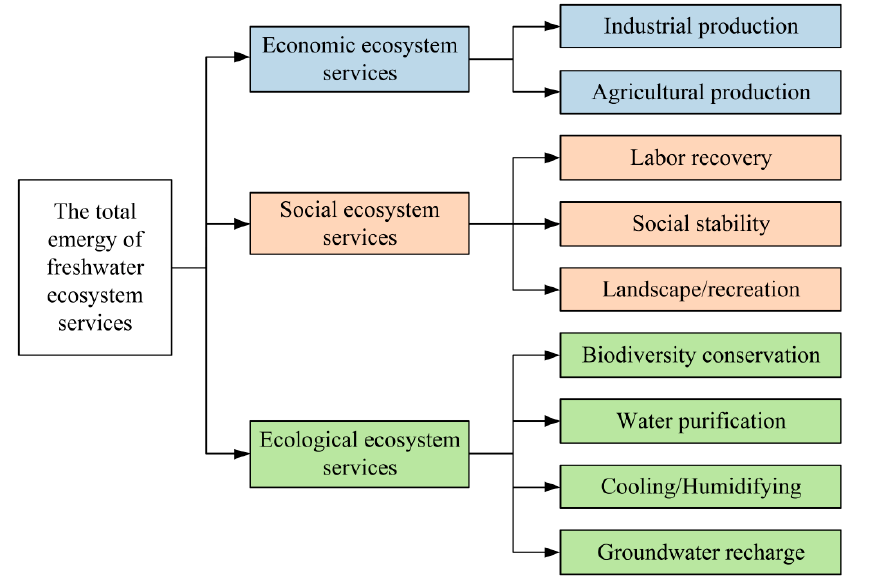
Figure 2. Economic, social, and ecological components of freshwater ecosystem services in the Qingyi River Basin, Xuchang, China.